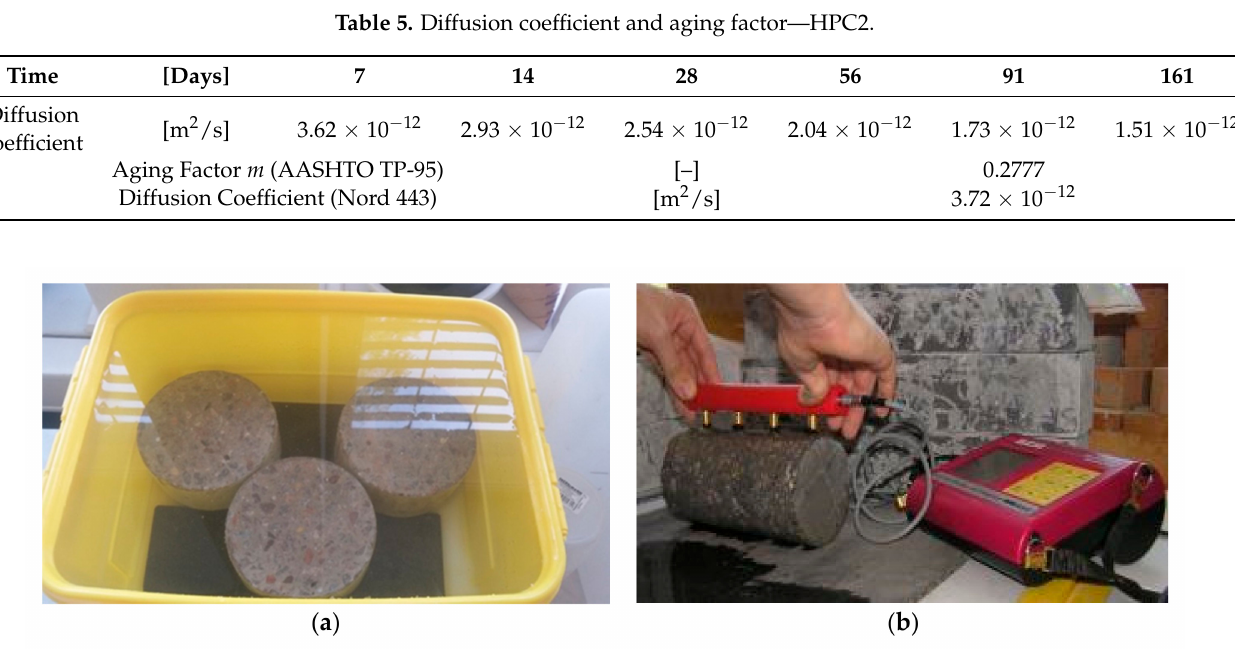
Figure 4. Specimens in chloride solution prepared for NT BUILD 443 test ( a ) and diffusion coefficient testing based on AASHTO TP-95 ( b ).